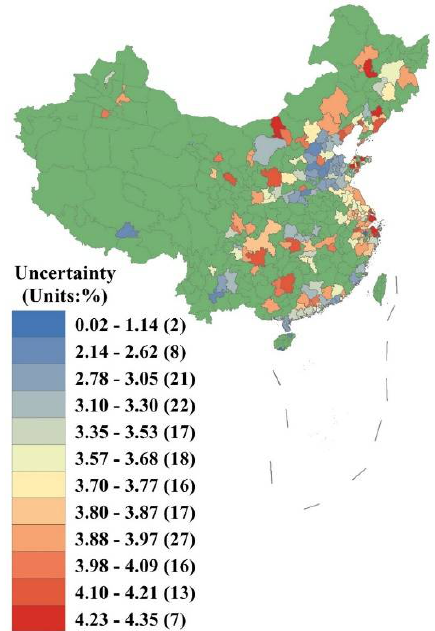
Figure 8. Spatial distribution of uncertainty in relation to health-related economic losses using the value of a statistical life (VSL).